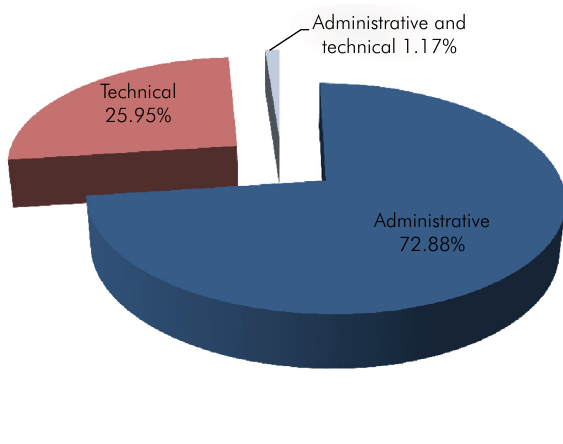
Figure. Frequency of denial types.